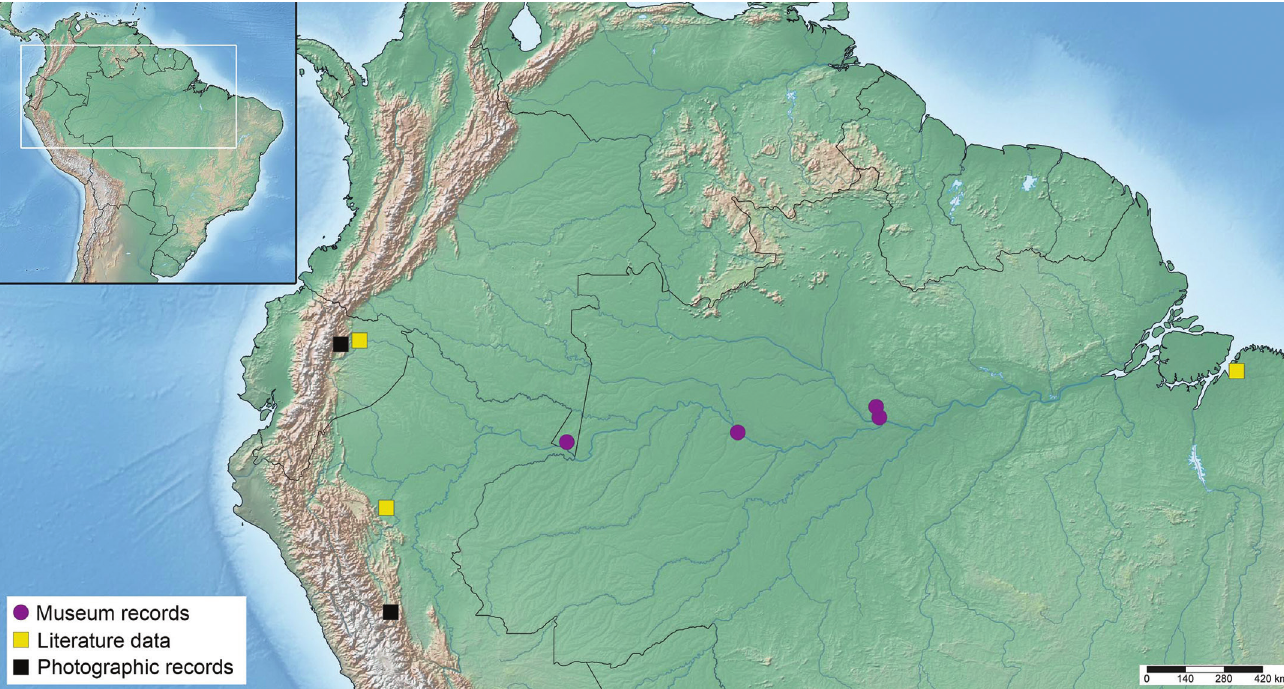
Fig. 12. Amorphopus notabilis distribution.